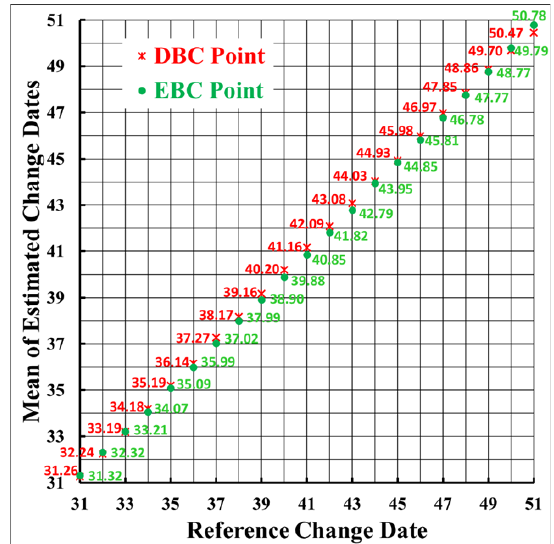
Figure 2. Mean of estimated change dates versus each reference change date. Figure 3. Study area at the north of Berlin Central Station. (a) Mean TerraSAR-X image. (b) Aerial image (Google Earth) acquired on September 5, 2014. Yellow square,